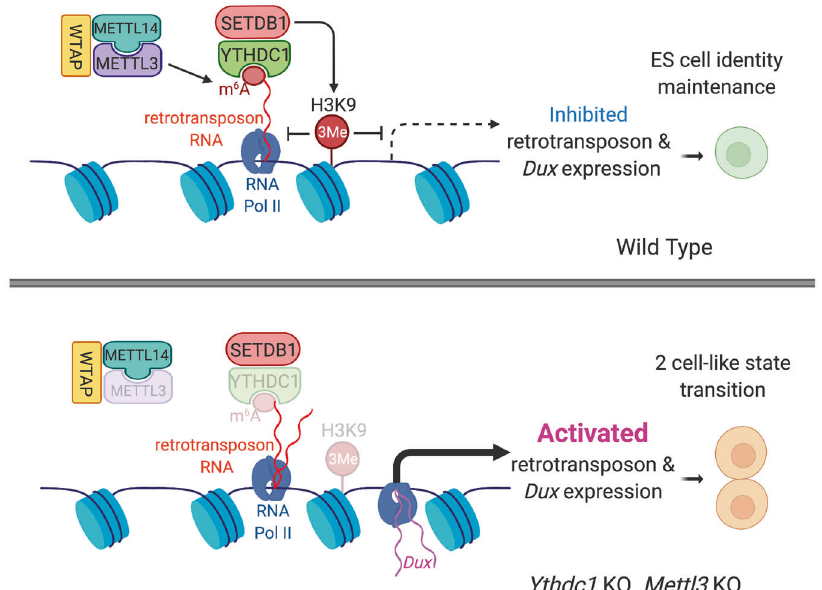
Fig. 1 Working model for the mechanism underlying m6A and YTHDC1-mediated maintenance of embryonic stem cell identity through chromatin silencing. Methylation of retrotransposon RNA recruits m 6 A reader YTHDC1 and H3K9me3 methyltransferase SETDB1 to promote retrotransposon chromatin silencing, which represses two-cell-like state transition, leading to embryonic stem cell identity